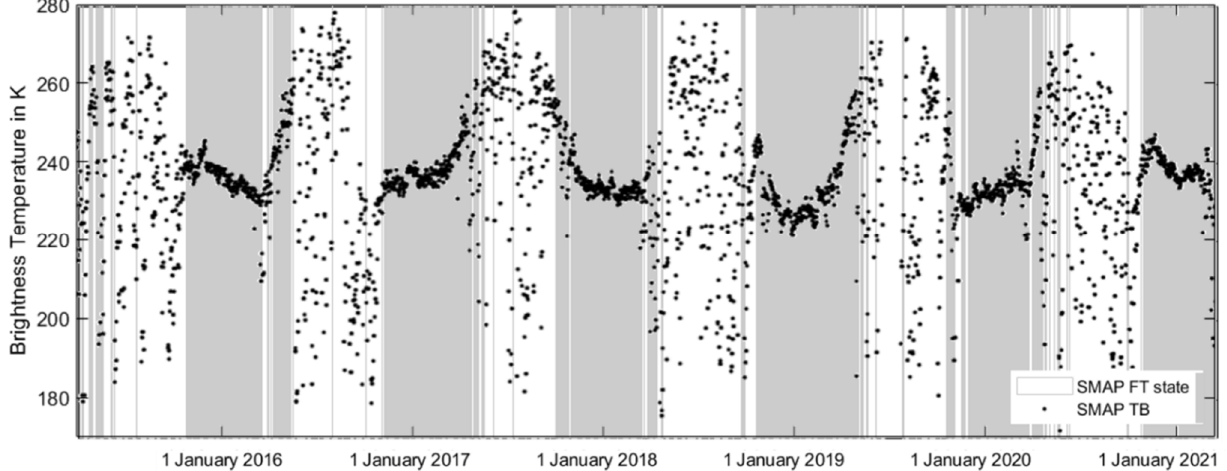
Figure 1. SMAP H-polarization TB time series and the derived reference FT state (grey for frozen and white for unfrozen) extracted for the location of the Xilinhot site (43°30’–45°N, 115°–117°E). When unfrozen, soil moisture variations due to evaporation lead to TB increases of only up to 15 K in a day [33]. An exception to significant daily TB changes for unfrozen soil is precipitation, which can reduce TB s by tens of K. TB can change in the same range due to daily soil temperature variations via T eff ((Equations (4) and (5)). TB changes during FT transitions are in the range and larger than the precipitation signal because of the huge ε difference between frozen and unfrozen soil. When frozen, emissivity—and thus TB variations—are very small and only slightly depend on soil composition, such as